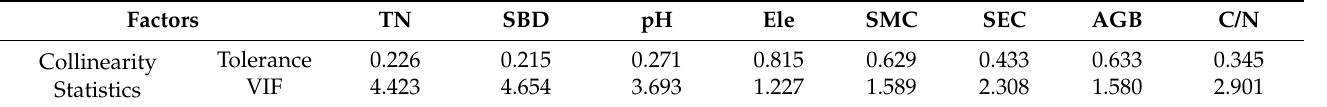
Table 4. Multicollinearity test among the environmental